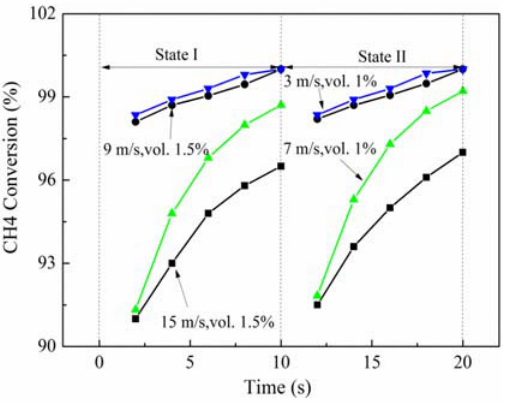
Figure 7. Effect of inlet velocities and concentrations on the methane conversion rate.